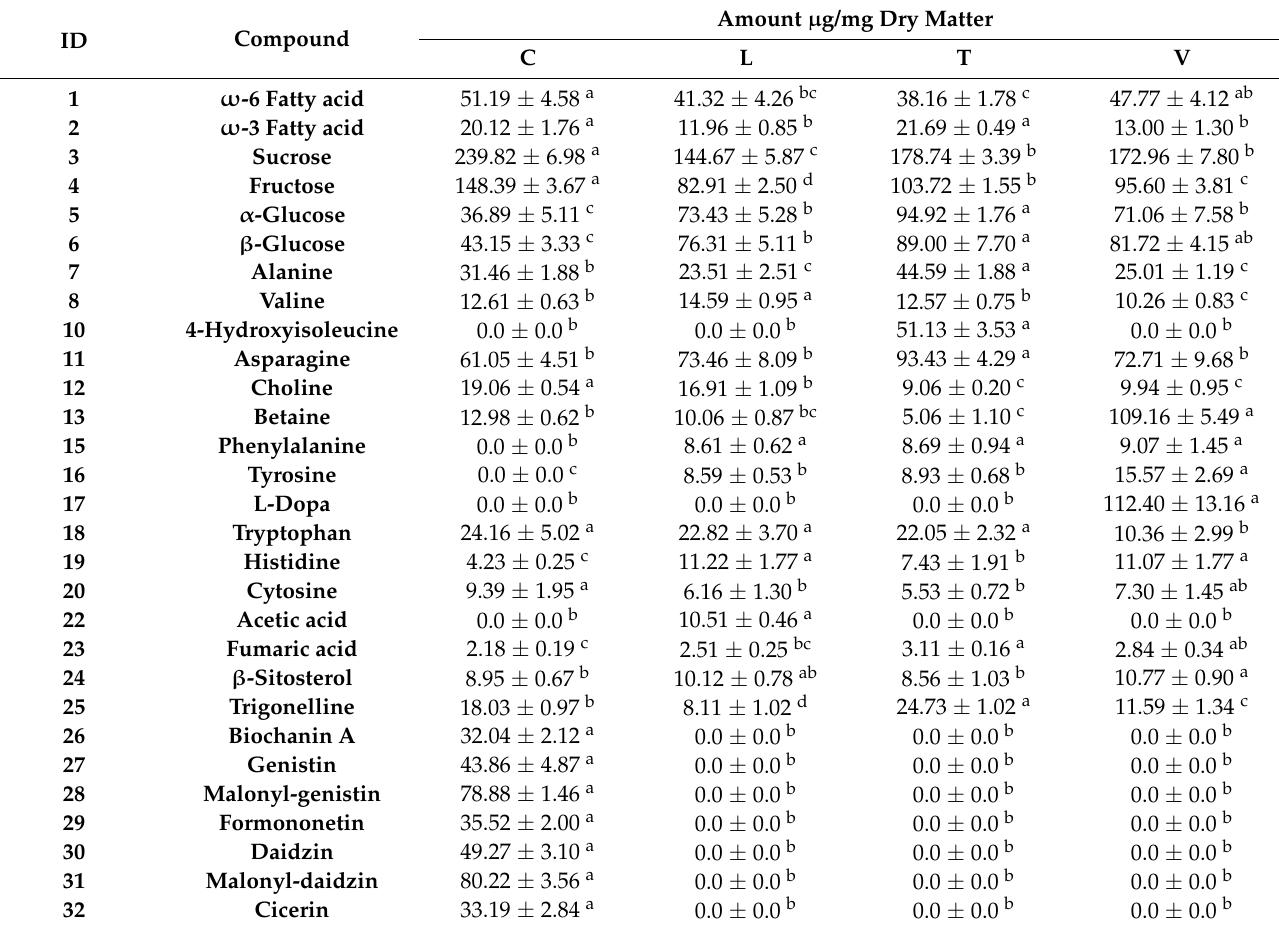
Table 2. 1 H-NMR quantification of major primary and secondary metabolites in different samples of legume sprouts methanol extracts (C, Cicer ; L, Lens ; T Trigonella ; V, Vicia ). Values are expressed as µ g/mg dry powder ± S.D ( n = 3), see experimental section. Chemical shifts used for metabolite quantification were determined in methanol- d 6 and expressed as relative values to HMDS (0.94 mM final concentration) Statistical analysis is carried out by one-way analysis of variance (ANOVA) where unshared letters between groups are the significance value at p ≤